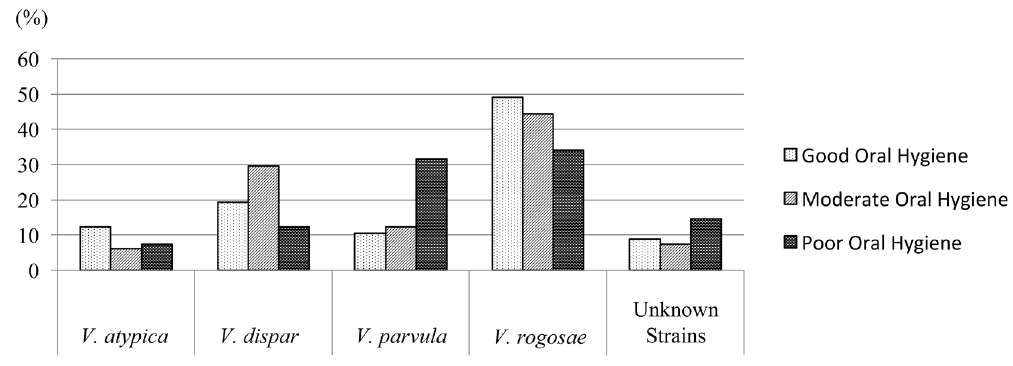
Figure 1. Total isolated number of each Veillonella species isolated. Data expressed as percentage of total the total isolated number as Veillonella in samples from saliva in good, moderate and poor oral hygiene groups.